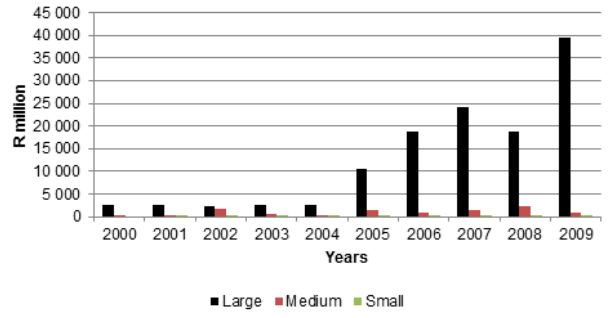
Figure 2: Share repurchase value based on market capitalisation